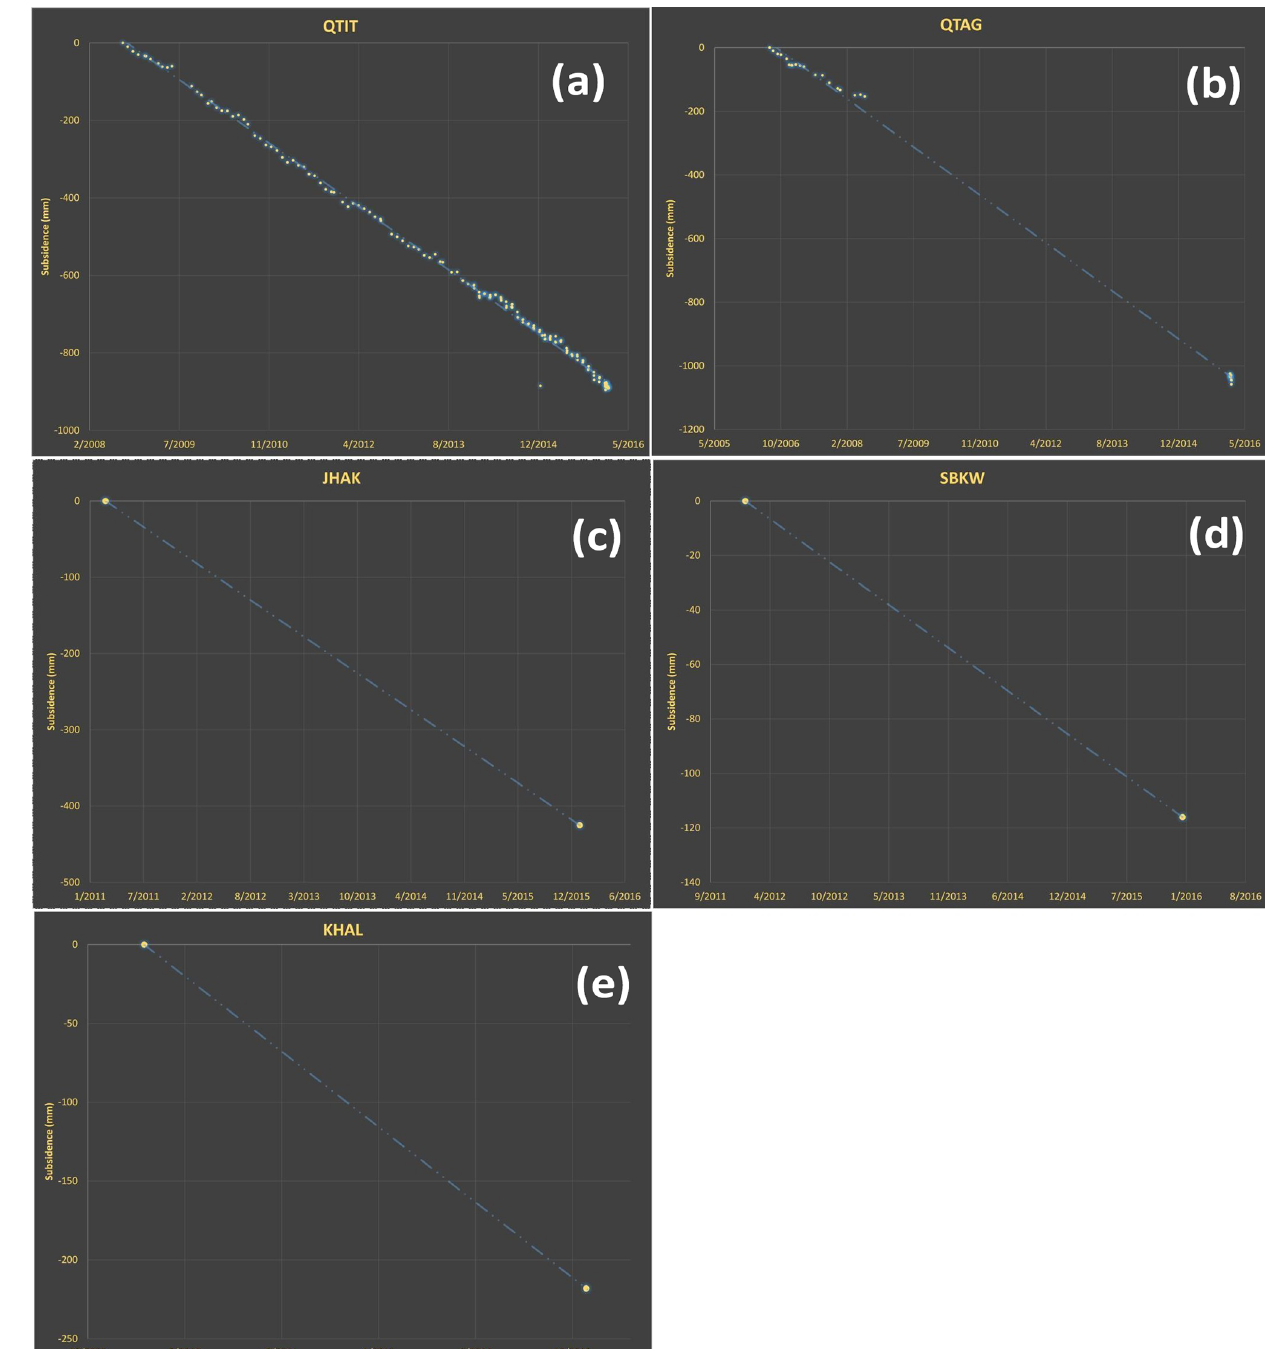
Figure 3. (a) Graph of GPS data for QTIT station, 120mmyr − 1 subsidence recorded on this site. (b) Graph of GPS data for QTAG station, 106mmyr − 1 subsidence recorded on this site. (c) Graph of GPS data for JHAK station, 88.3mmyr − 1 subsidence recorded on this site. (d) Graph of GPS data for SBKW station, 29mmyr − 1 subsidence recorded on this site. (e) Graph of GPS data for KHAL station, 35.1mmyr − 1 subsidence recorded on this